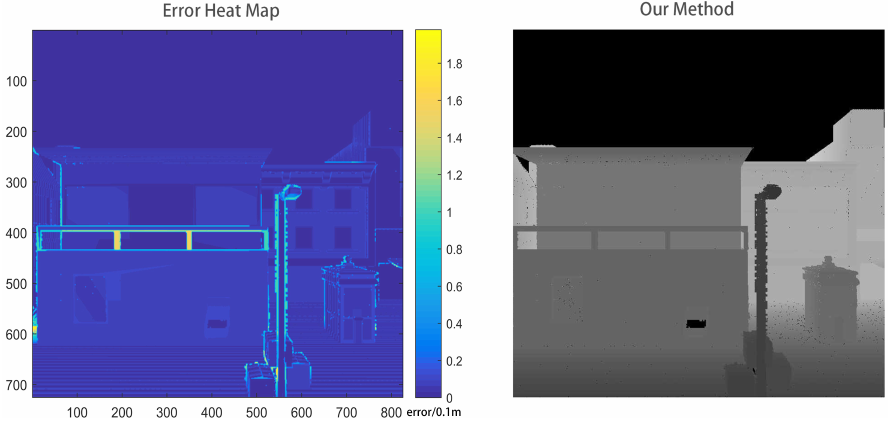
Figure 7. Reconstruction error of our